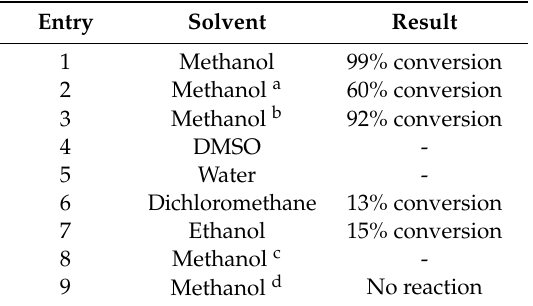
Table 2. Influence of the reaction conditions and catalyst choice on the result of the reaction. Entry